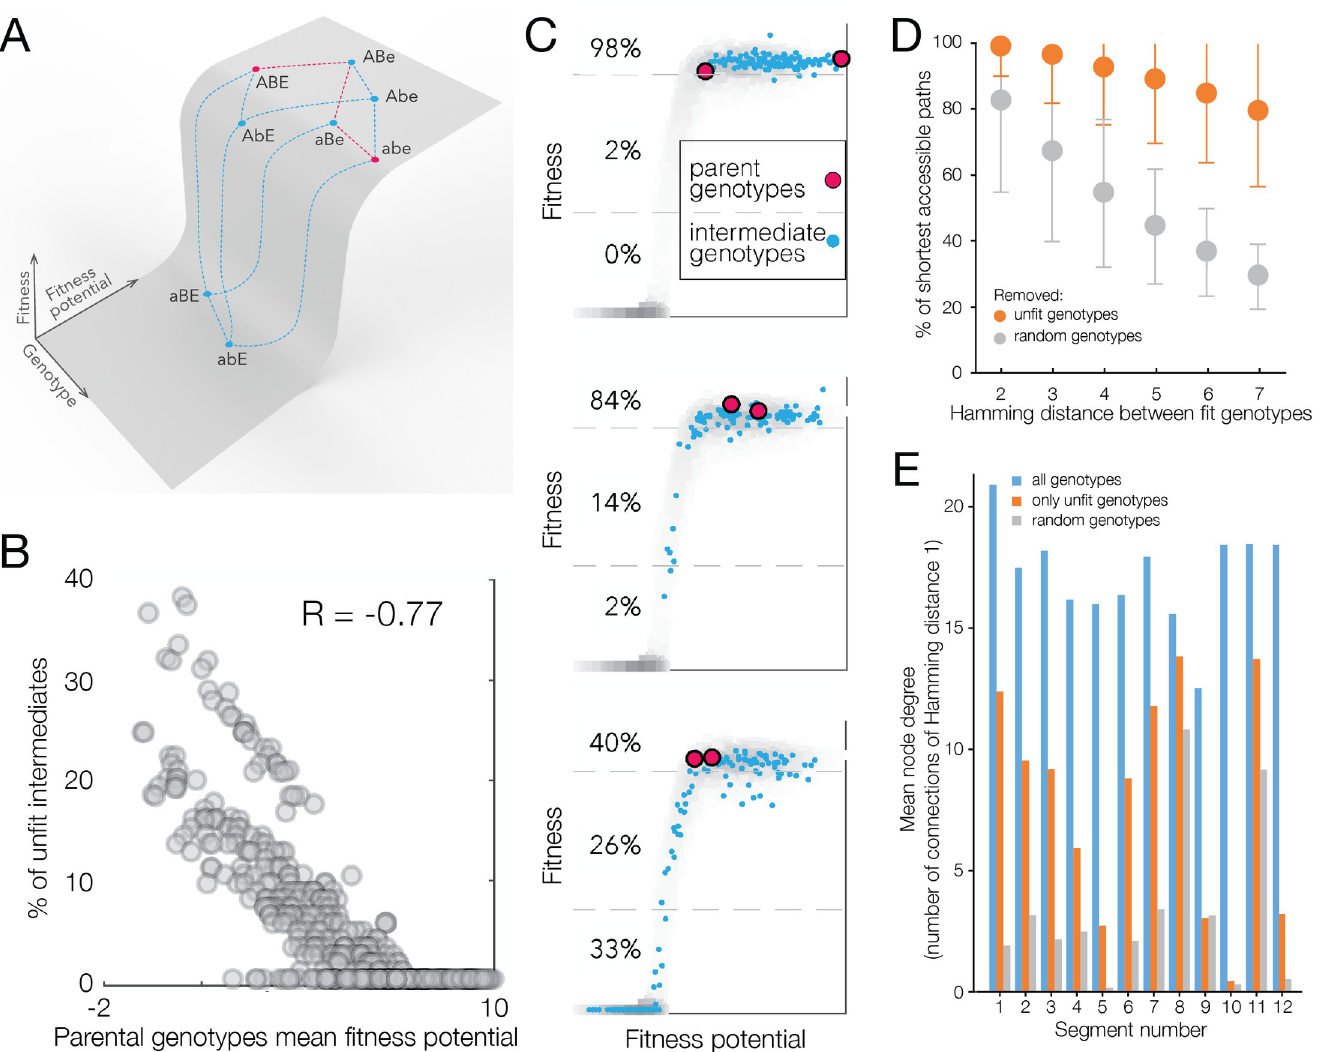
Fig 7. Analysis of evolutionary pathway accessibility. a, A threshold fitness potential function can lead to some paths being inaccessible between two genotypes of high fitness (abe, ABE) if the joint contribution of several alleles to the fitness potential (abE, aBE) leads to the fitness potential below the threshold. b, The fraction of unfit intermediate genotypes between two fit genotypes as a function of their average fitness potential. c, The grey area represents all genotypes in segment 7. When two fit genotypes (red dots) have high fitness potential, many paths between them will be accessible because many intermediate genotypes will also have high fitness potential and fitness (blue dots). d, Two fit genotypes in our dataset with intermediate genotypes between them. Intermediate genotypes are those that can be found between the two genotypes when making amino acid replacements from one genotype to the other. By this definition, the intermediate genotypes are located on the shortest paths connecting the two genotypes, with shortest paths are those that include only forward replacements. Accessible paths are those that incorporate only fit genotypes. The fraction of accessible shortest paths between two fit genotypes from data (orange) shows a modest decline as a function of Hamming distance between the two genotypes. The fraction of accessible shortest paths between two fit genotypes declines more rapidly when the same number of unfit genotypes as observed in real data are randomly drawn from intermediate genotypes (grey), demonstrating that in real data unfit genotypes are clustered in sequence space. Error bars are standard deviation. e, Genotypes can be represented by a graph with edges connecting genotypes if they can be connected by one amino acid replacement. We calculate the degree of connectivity (number of edges for each node) when all genotypes one replacement away are connected (blue), only unfit (fitness = 0) genotypes are connected (orange) and when unfit genotypes are connected with unfit genotypes selected at random keeping the same number of unfit genotypes as in our data (grey). With the exception of segment 9, in all segments the connectivity of unfit genotypes is higher than random, confirming that unfit genotypes are clustered in sequence